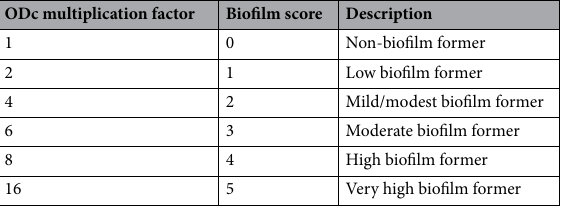
Table 1. Biofilm